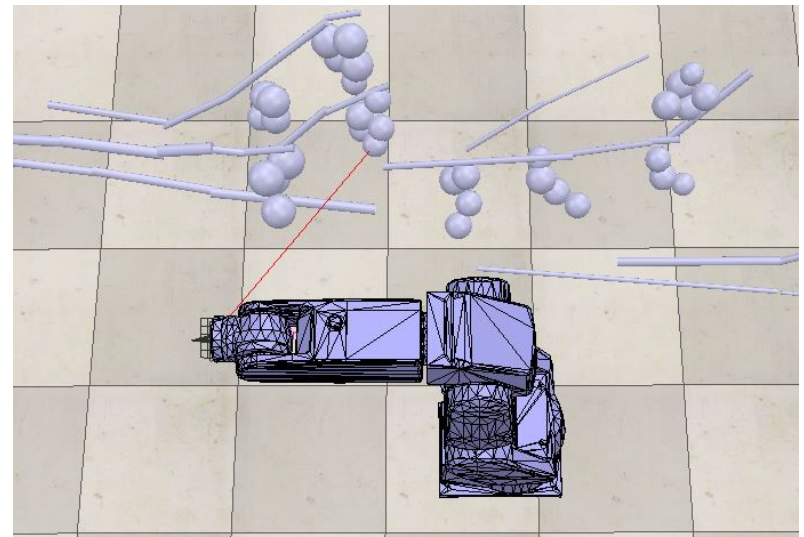
Figure 9. Robot initial